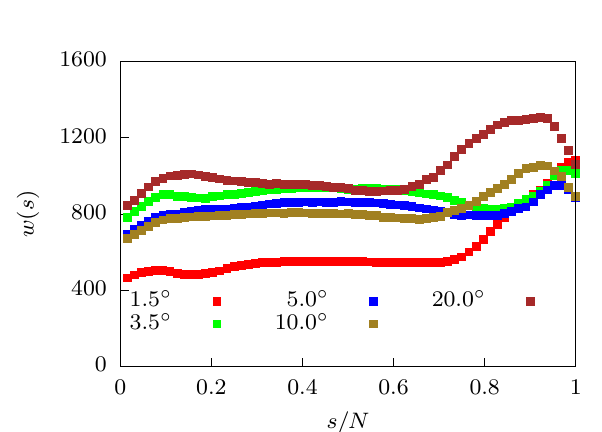
Figure 7. Passage time ( τ p ) and escape time ( τ e ) contributions to the total translocation time for a flexible polymer at a low force value, f 0 = 0.2 .